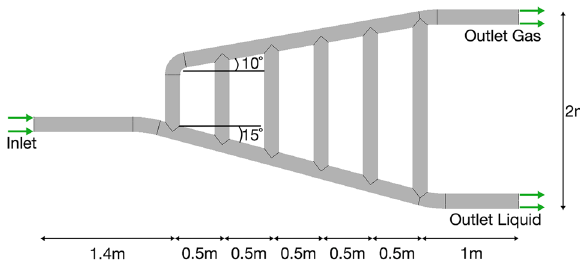
Fig. 2 Separator geometry and location of boundary